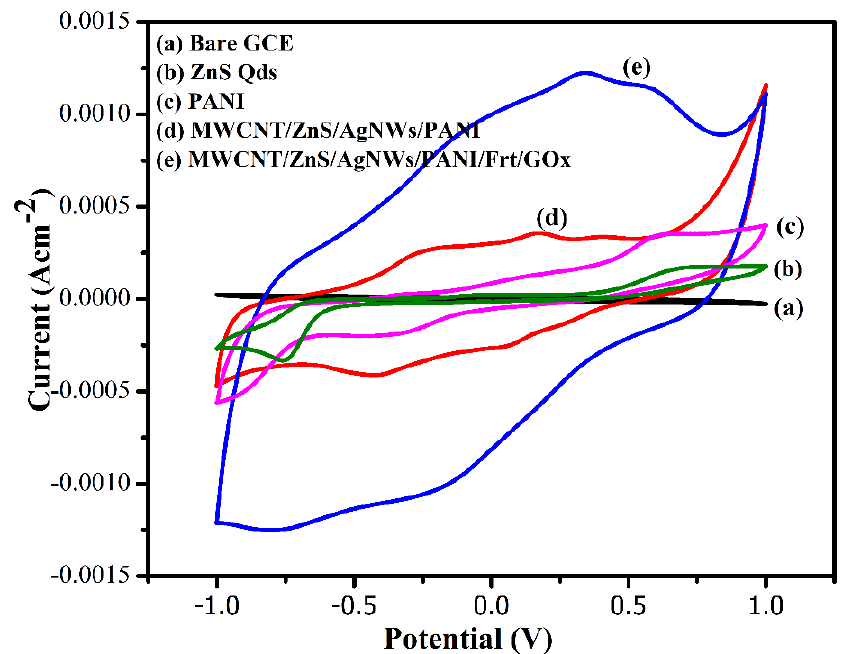
Figure 8. Cyclic voltammograms of: ( a ) bare GCE; ( b ) GCE/ZnS Qds; ( c ) GCE/PANI; ( d ) GCE/MWCNT/ZnS/AgNWs/PANI; ( e ) GCE/(MWCNT/ZnS/AgNWs/PANI/Frt/GOx in PBS pH 7.0 as supporting electrolyte at ambient conditions.